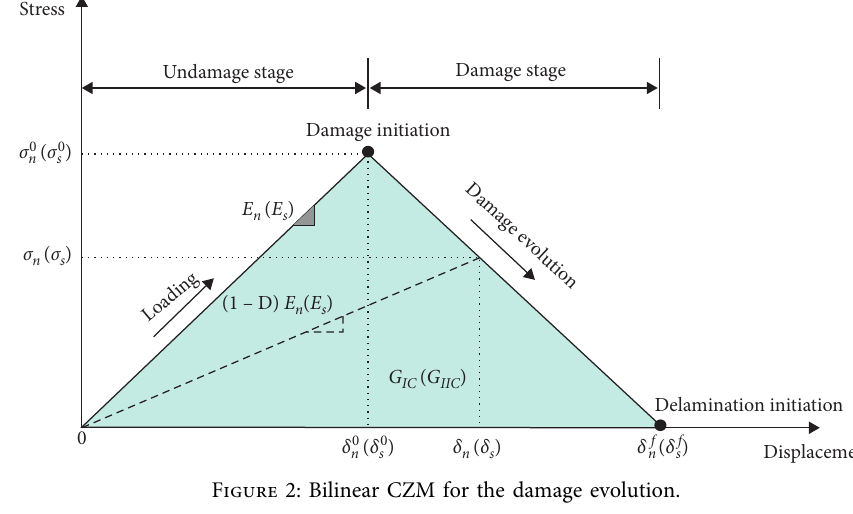
Figure 2: Bilinear CZM for the damage